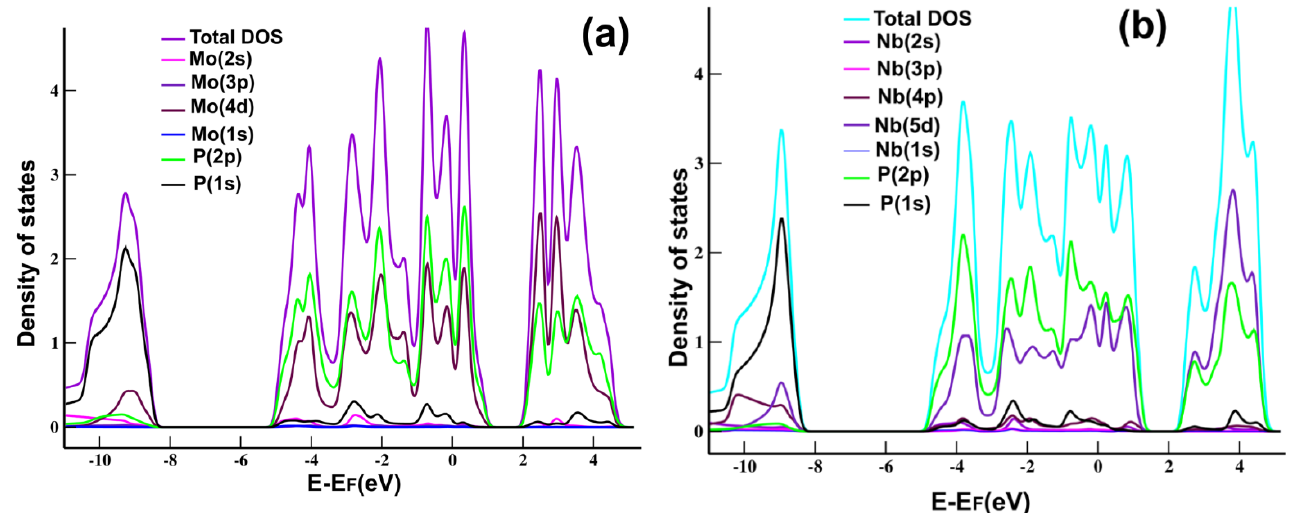
Figure 2. ( a ) PDOS for 2D MoP 2 . We can see the hybridization of states s and p of Mo and P. We present the orbitals d from Mo; ( b ) PDOS for NbP 2 . We can notice the hybridization of states s and p of Nb and P. We also show the orbitals d from Nb.